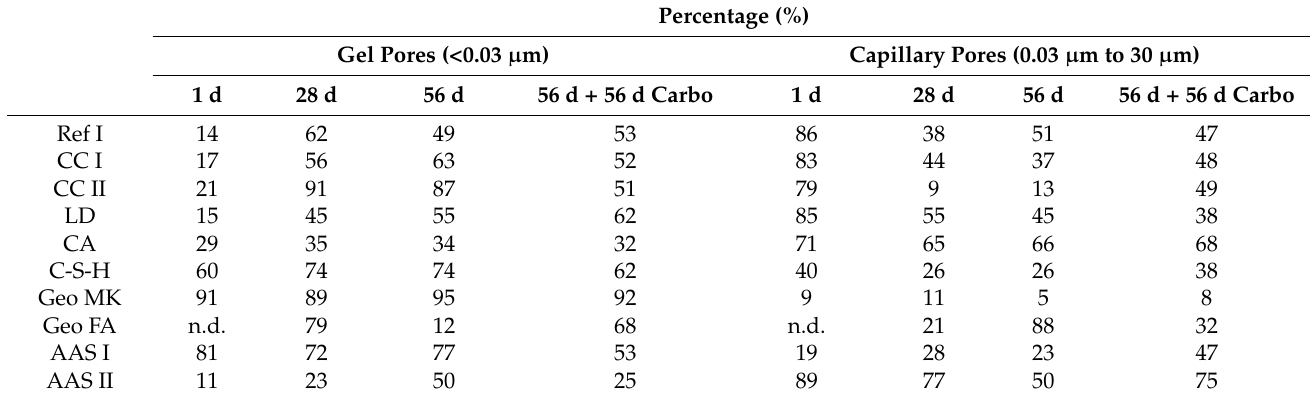
Table 3. Pore size distribution.